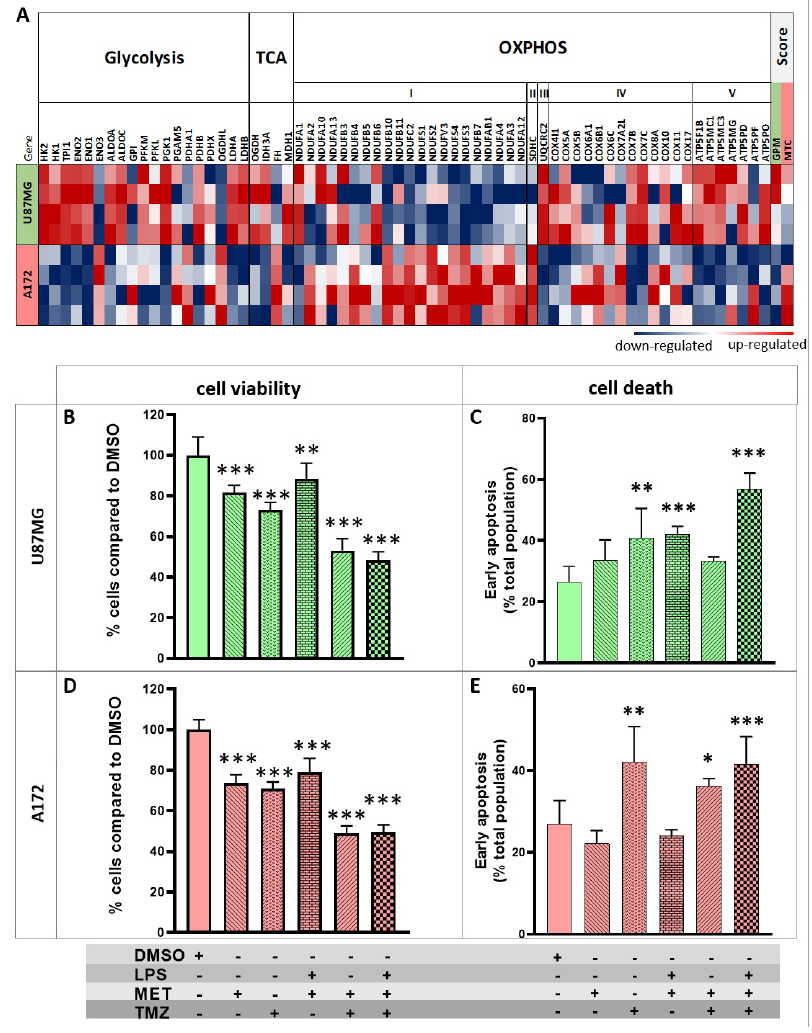
Figure 2. Cell viability and death assays for A172 and U87MG treatment with LPS, MET, and TMZ. ( A ) Heatmap presenting expression values for the genes related to glycolysis, TCA cycle and oxidative phosphorylation normalized by z − score. A score value for the expression of genes attributed as a marker for glycolytic plurimetabolic (GPM) and mitochondrial (MTC) GBM subtypes according to Garofano’s (2021) classification [32]. Upregulated genes are presented in red and downregulated genes in blue. Graph bars representing the viability plotted for the single and combined treatments for LPS, MET, and TMZ in U87MG; ( B ) and A172 ( D ) after 48 h of treatment (**) p < 0.01, (***) p < 0.001 by one − way ANOVA post hoc Tukey test. Cellular death was analyzed by flow cytometry 48 h after treatments for U87MG; ( C ) and A172; and ( E ), and the results for initial apoptosis are presented. The graphs represent the percentage of the population in initial apoptosis through the positivity for annexin and PI negative in bars for each treatment condition. (*) p < 0.05, (**) p < 0.01, (***) p < 0.001 by two − way ANOVA post hoc Tukey